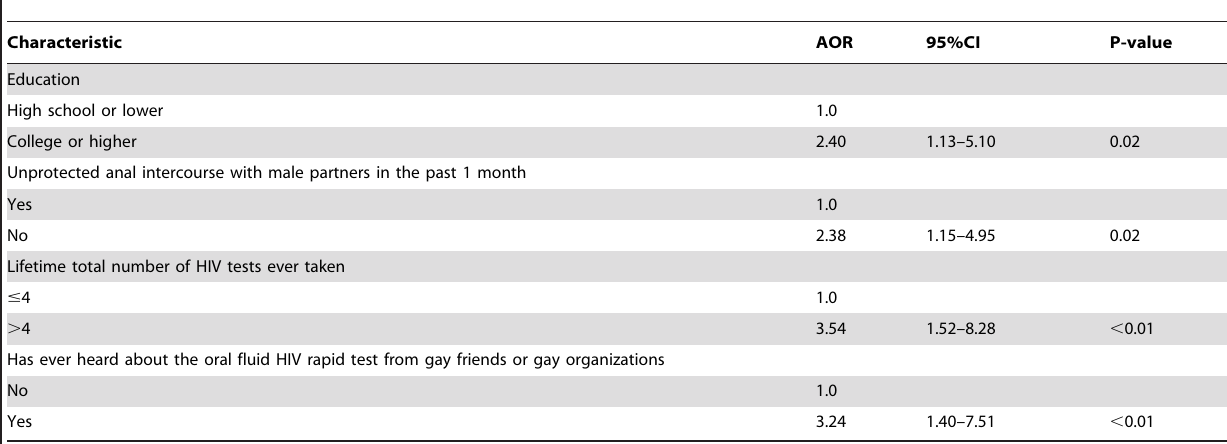
Table 3. Multivariate logistic regression analysis of factors associated with willingness to use oral fluid HIV rapid test, among Men who have sex with men in Beijing, China.